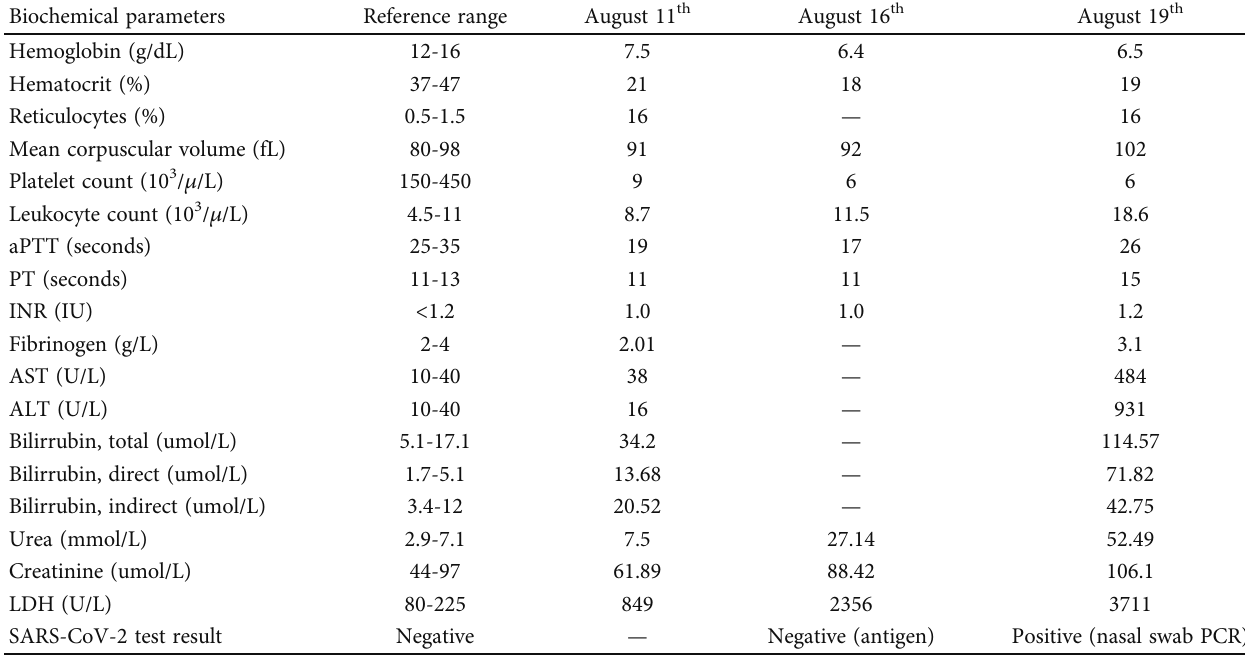
Table 1: Sequential laboratory tests.